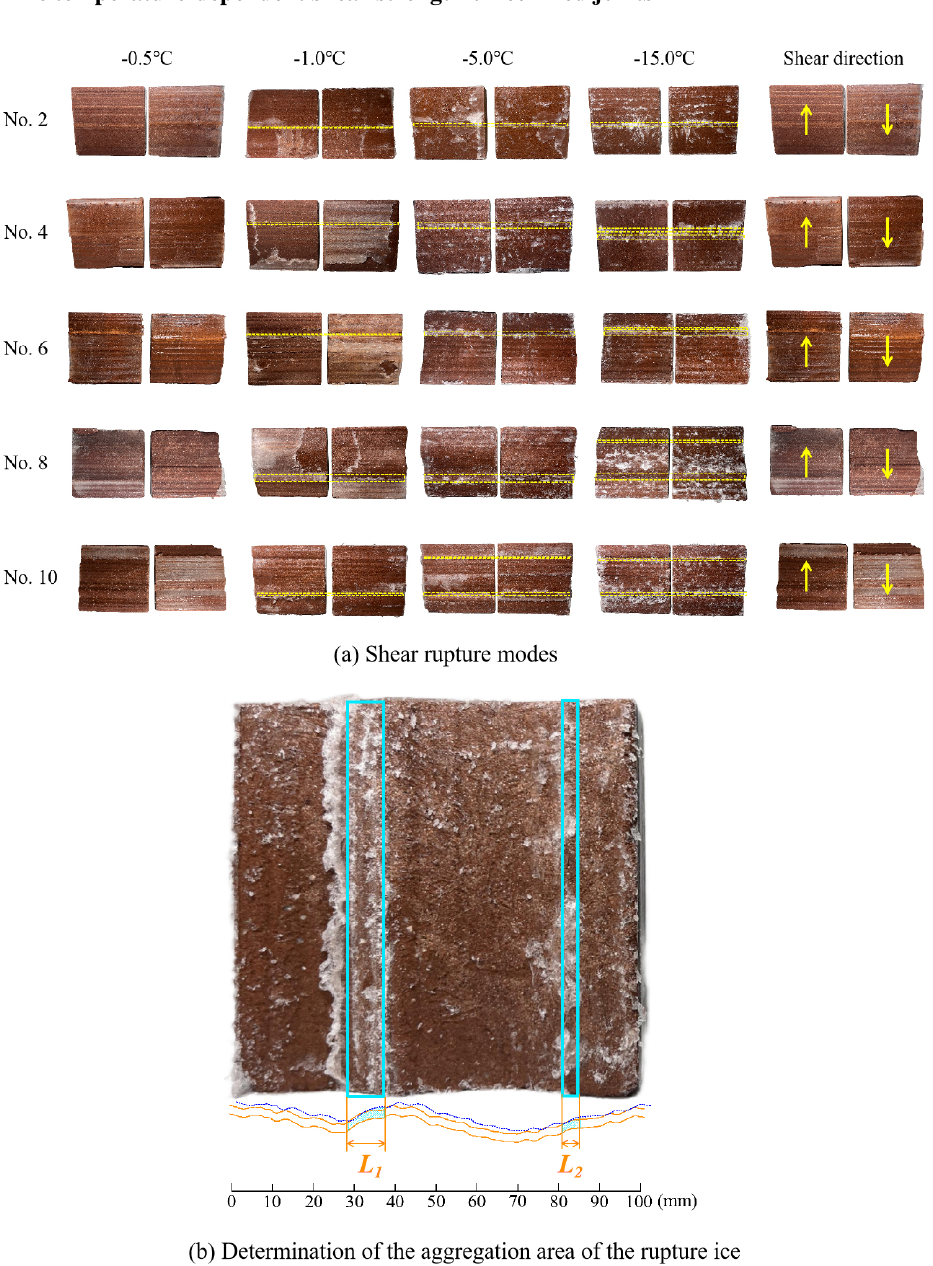
Figure 6. Shear rupture modes and aggregation area of ice-filled joints at different freezing temperatures. The dotted yellow lines show the main aggregation of rupture ice. Ice after rupture aggregates in roughness bulges perpendicular to the shear